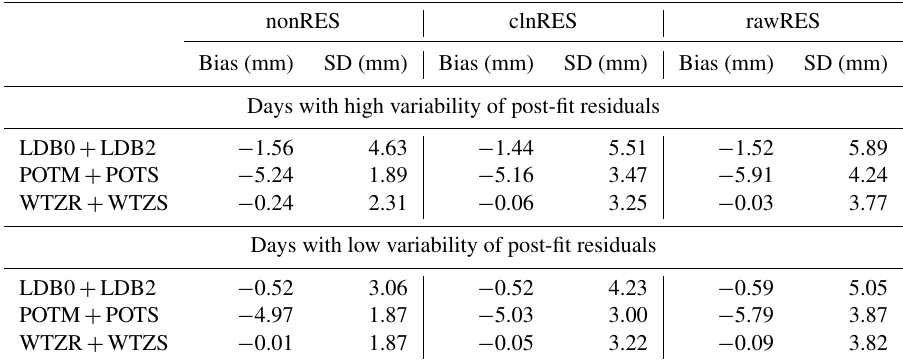
Table 7. Comparison of GNSS STDs from the elevation angles ranging from 7 to 15 ◦ at three dual stations; results for days with high daily variability of cleaned post-fit residuals (top) and results for days with low daily variability of post-fit residuals (bottom). Median values of biases and standard deviations (SD) calculated over all GNSS STD solutions are given; statistics are expressed in the zenith direction.